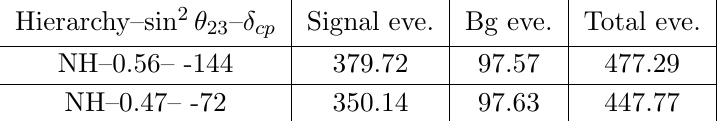
{ (cid:14) Signal eve. 23 cp